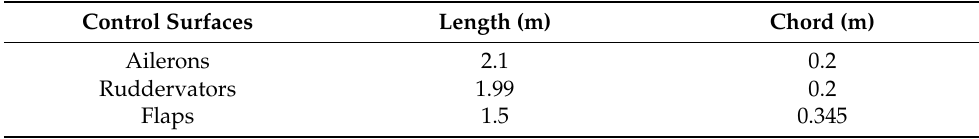
Table 10. Control surface